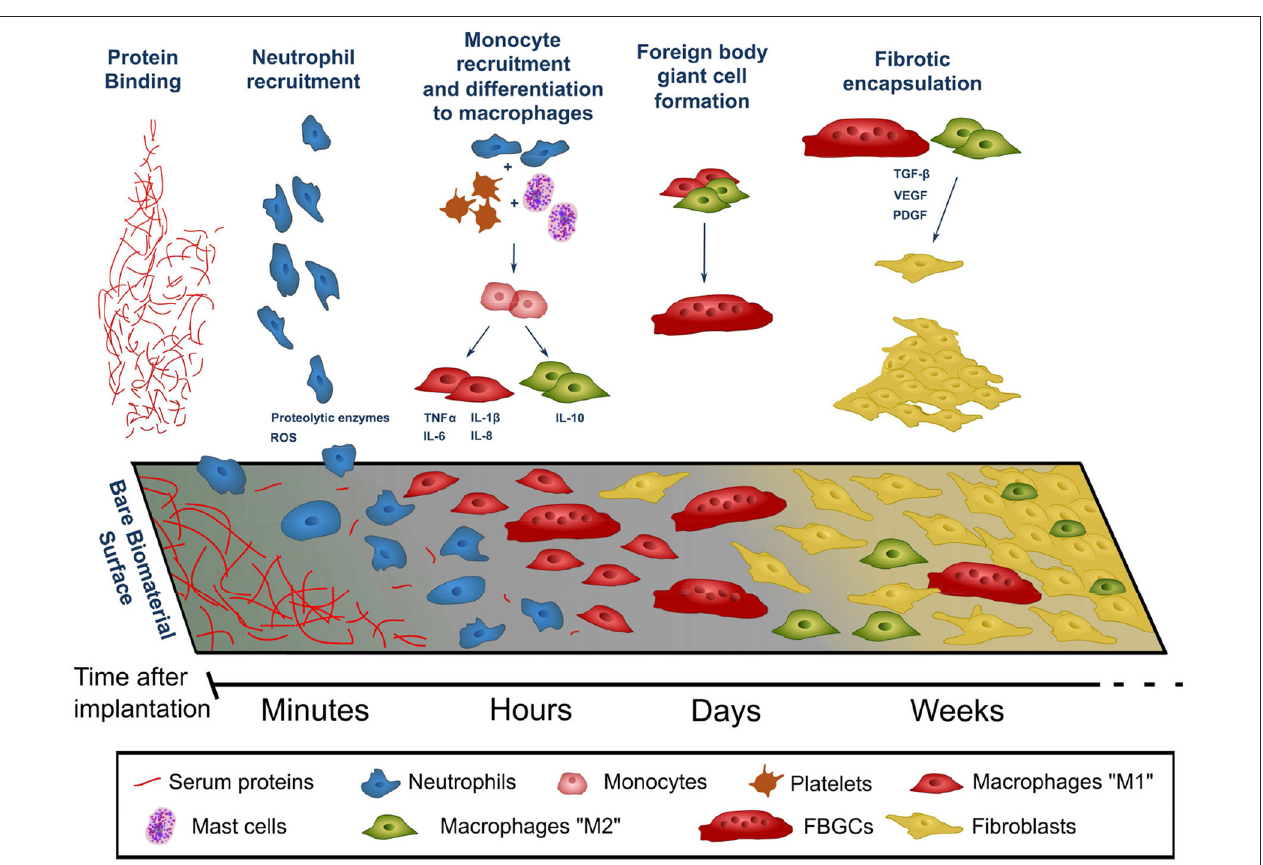
FIGURE 1 | Timeline of the events leading to the development of the foreign body reaction to a material following its implantation into the body. The composition of the cell population adhered to the surface of the implant evolves over time following the initial implantation. Factors released by cells (indicated by blue text) contribute to the recruitment of further cells and progression of FBR. ROS, reactive oxygen